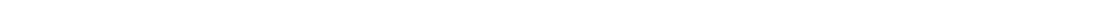
V55, S57, P58, and S66 residues interact with the E2 ’ s residues S239, R244, Q247, and S249 (Fig. 2b). This fi rst region is located near the tip of E1 ’ s domain II and the E2 ’ s β -ribbon, which is similar to that of other alpha- viruses (e.g., E1 S57 with E2 H164 in SINV 22 ; and E1 S57